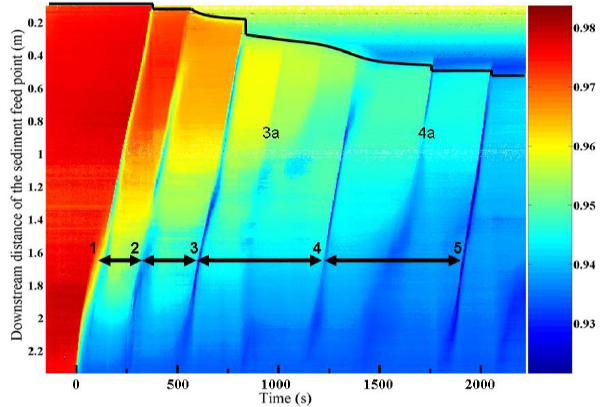
Figure 3. Geomorphic evolution of the alluvial reach in Run 2. Plot illustrating the upstream migration of five prominent knickpoints, and two weak knickpoints, in response to the lowering of the weir by 5 cm at t = 0. The run in question is Figure 2. The bottom axis is time elapsed after the removal of the upper weir. For 120 s proceeding to t = 0, the entire alluvial river was graded (i.e. antecedent graded profile). Color index bar to the right documents relative bed elevation, as explained in the text.